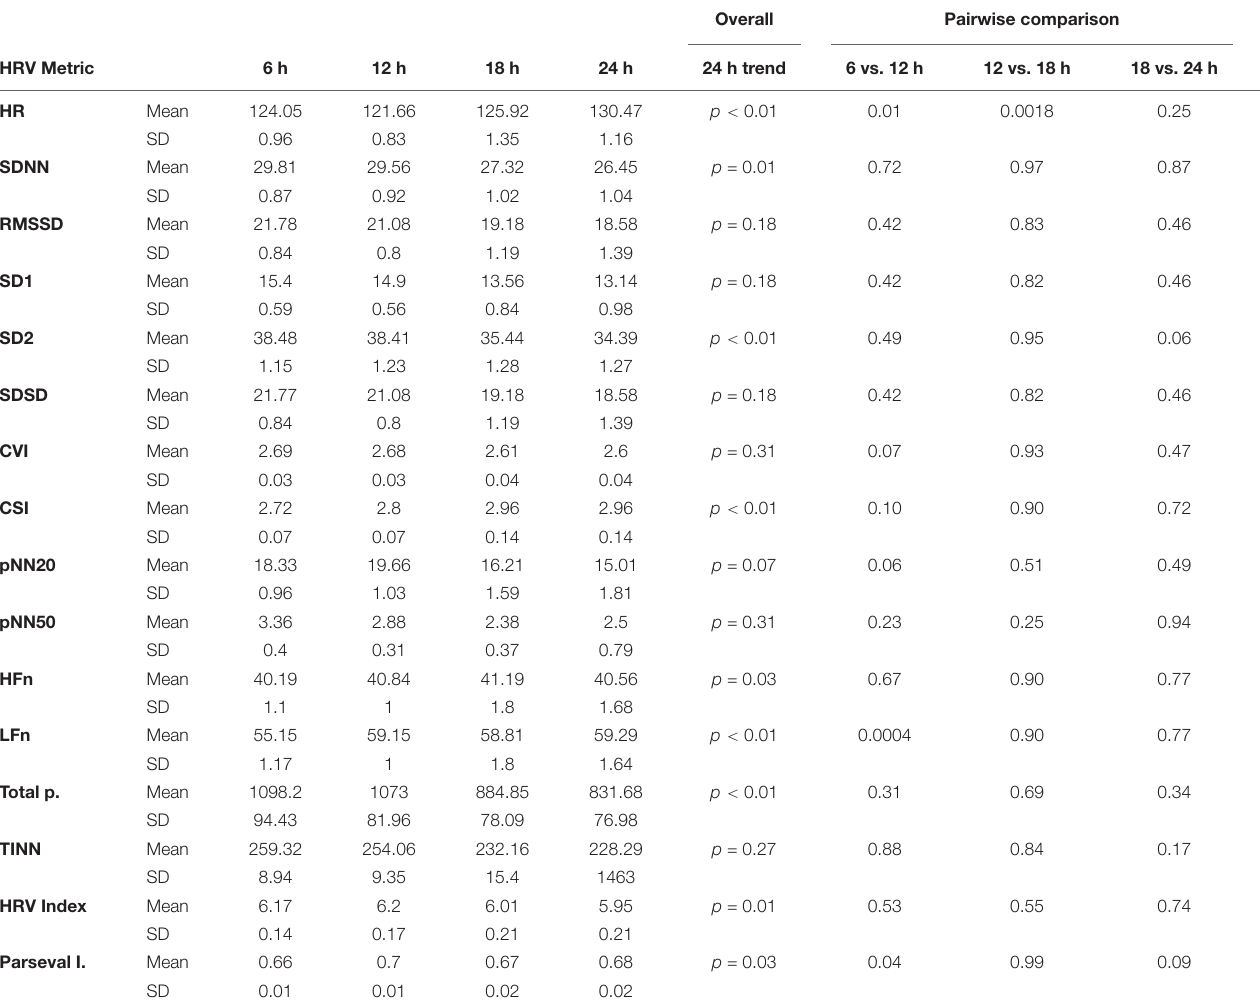
TABLE 4 | Six-hourly HRV averages and pairwise comparisons.